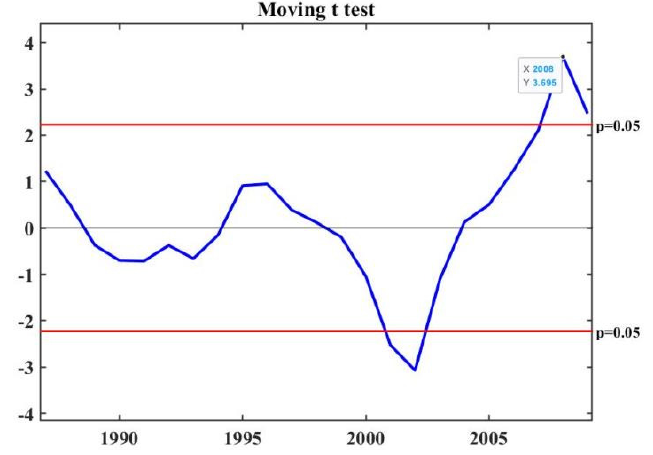
Figure 7. The results of the moving t-test.